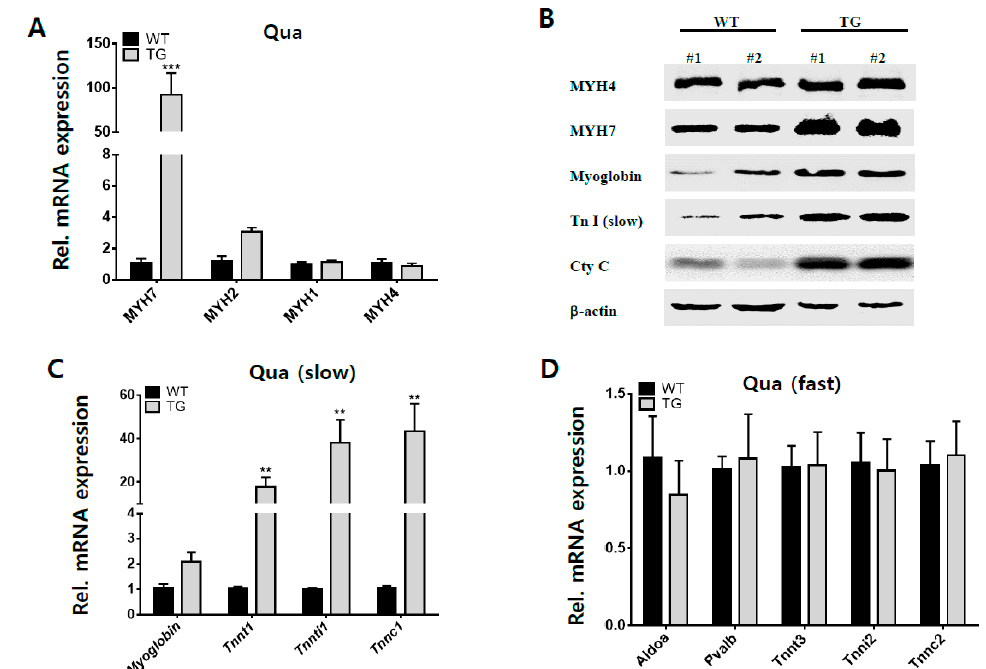
Figure 4. Expression of slow and fast muscle-associated genes in quadriceps muscles. ( A ) Myosin heavy chain gene expressions by qRT-PCR. Myh7 is represented as a slow muscle type, whereas Myh2 , Myh1 , and Myh4 are fast muscle types. ( B ) Comparisons of protein levels associated with slow muscle types between WT and TG in quadriceps muscle by western blotting. Overall, slow muscle type associated proteins were up-regulated in quadriceps muscles of TG mice. ( C ) Analysis of slow muscle-associated genes expression by qRT-PCR. ( D ) Analysis of fast muscle-associated genes expression by qRT-PCR. These data were from four-month-old wild-type ( n = 4) and transgenic mice ( n = 5), which were normalized according to the amount of mouse Gapdh mRNA and expressed relative to the corresponding value of the wild-type mice. Data are expressed as the means ± SEM for three independent replicates and multiple t -tests were used for the statistical analysis. * = p < 0.05; ** = p < 0.01; *** = p < 0.01.